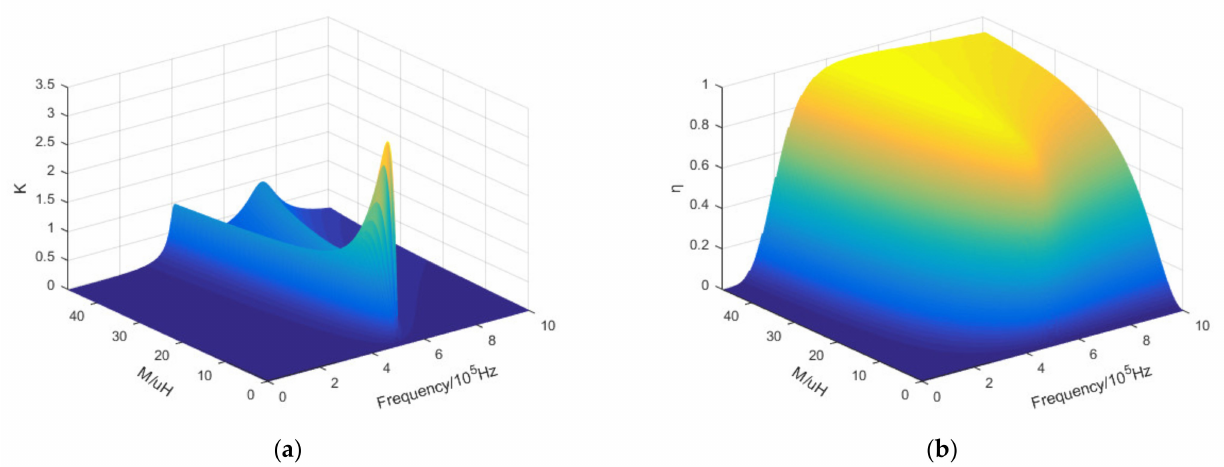
Figure 4. ( a ) The relationship between voltage modulus gain K , inverter frequency f , and mutual inductance M ; and ( b ) the relationship between efficiency η , inverter frequency f , and mutual inductance M